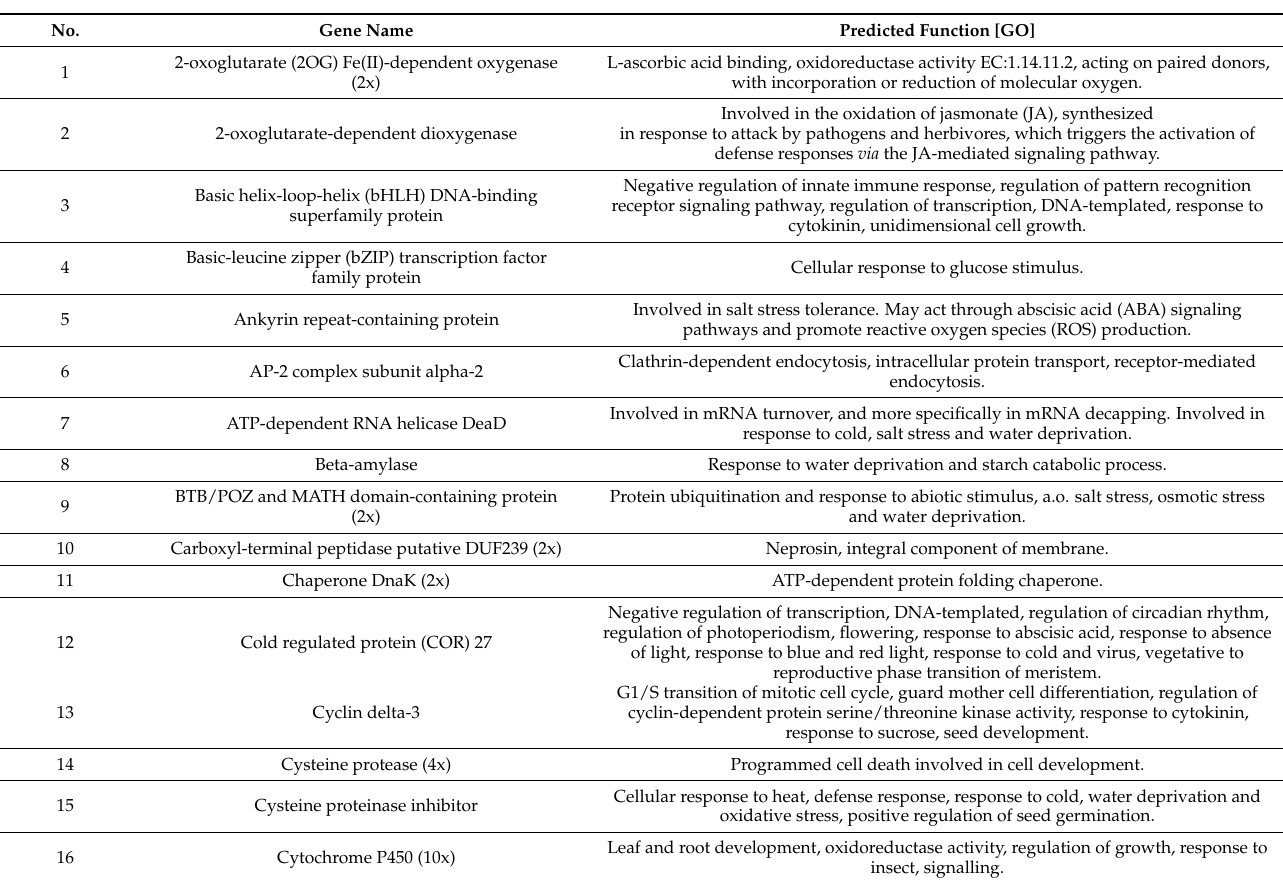
Table 3. Other genes located in a section of chromosome 5R in rye